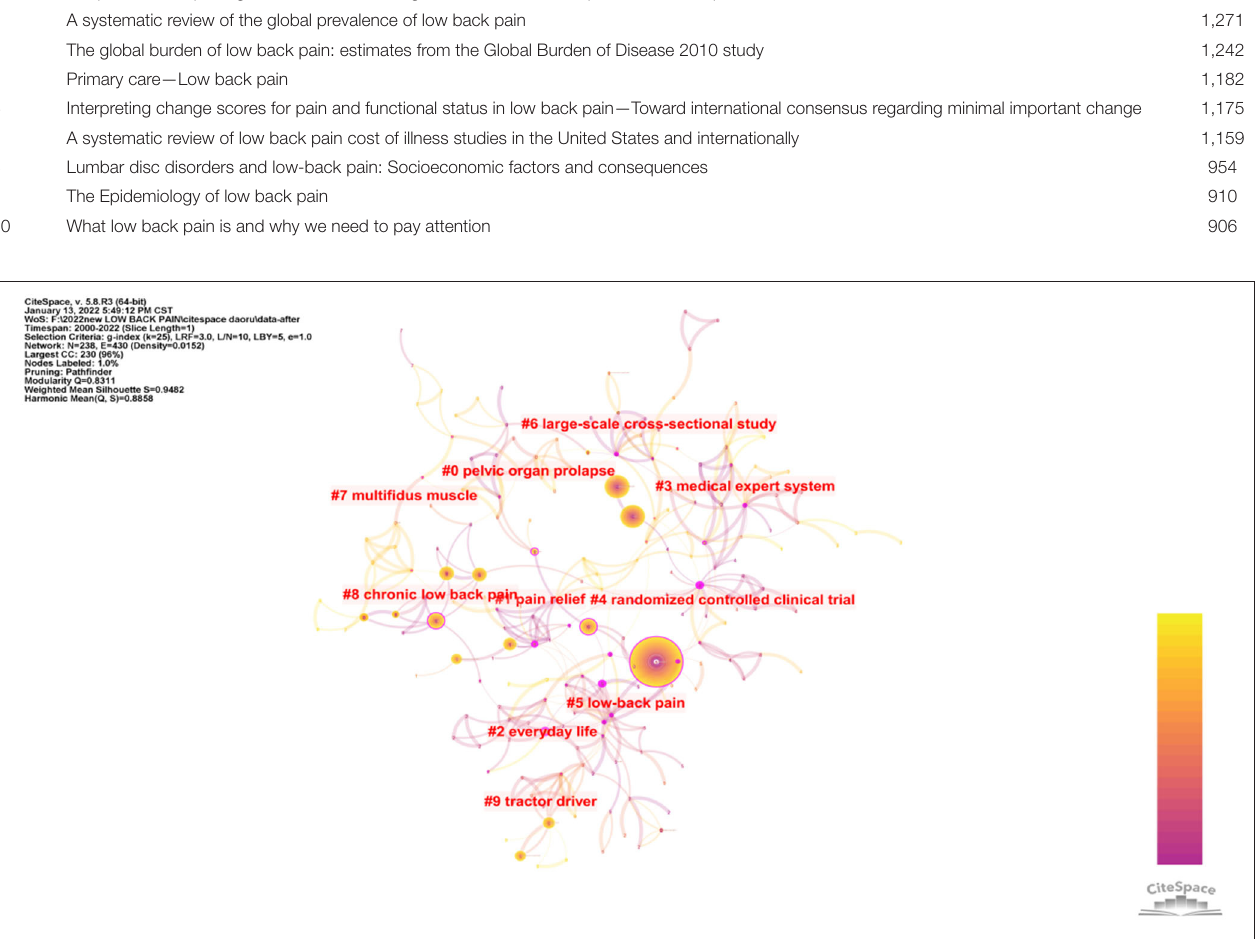
Figure 3 , the publication outputs went through a period of fluctuation between 2000 and 2007. Conversely, the number of published articles increased rapidly after 2008. In order to clearly predict the trend of LBP studies, Pearson’s correlation analysis was performed and revealed that the publication outputs are moderately correlated to the year of publication ( r = 0.682, p = 0 <